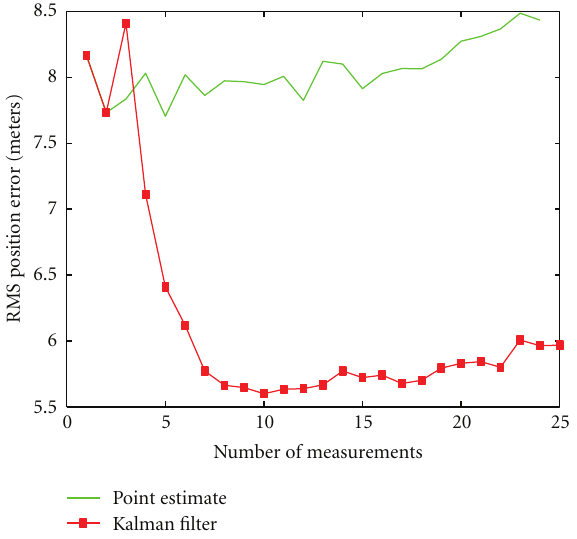
Figure 6: Root-mean-squared (RMS) localization error as a function of the number of measurements acquired as the receiver moved in a straight line.